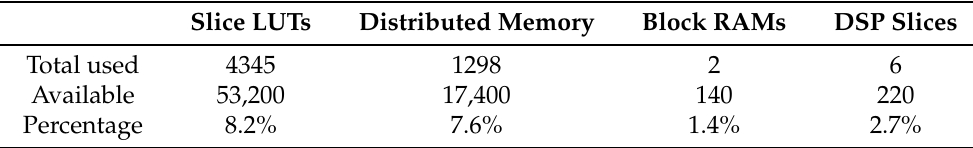
Table 2. Resource utilization of the digital coprocessor on a Xilinx XC7Z020 FPGA.